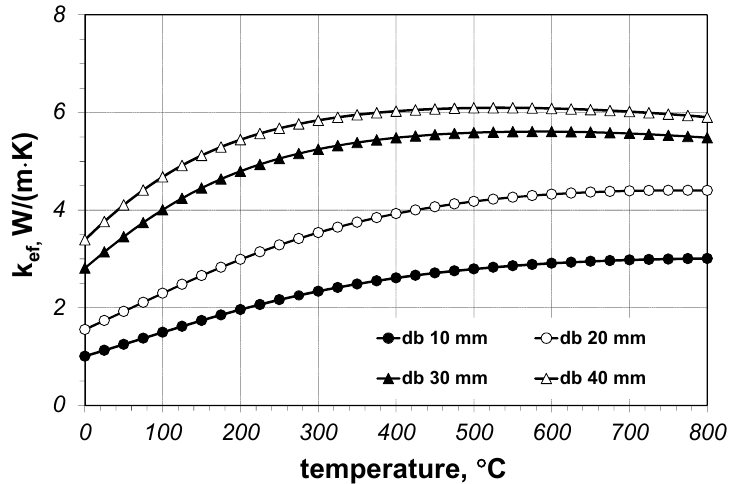
Figure 8. The results of calculations of the effective thermal conductivity k ef obtained with the use of the Krischer model for a simplified solution.